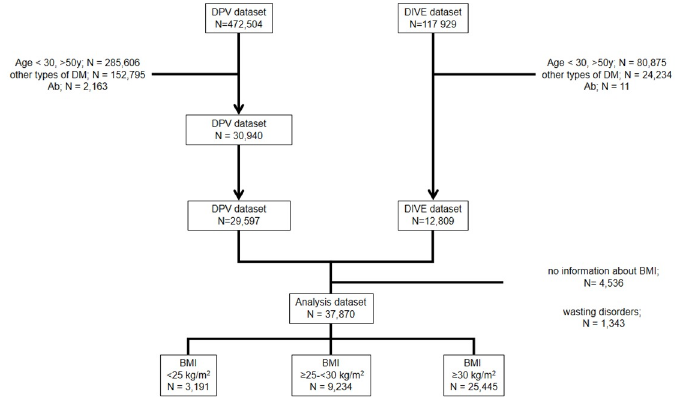
Fig 1. Patient flow. DM: diabetes mellitus; Ab: beta-cell autoantibodies; wasting disorders: malignancies, tuberculosis, chronicpancreatitis, alcoholism;BMI: body mass index.